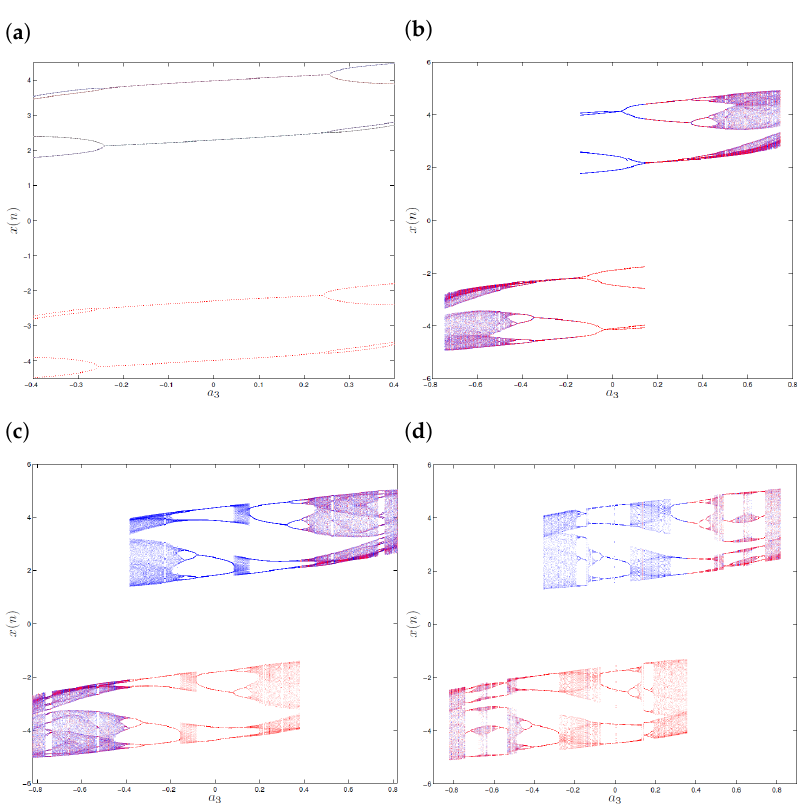
Figure 4. Bifurcation diagrams versus a 3 of the fractional memristor map (12) with no fixed points for a 2 = 0.8, a 1 = 2.1, ICs ( 1,2 ) and ( − 1, − 2 ) ; and fore fractional-order values: ( a ) α = 0.98, ( b ) α = 0.85, ( c ) α = 0.8, and ( d ) α =